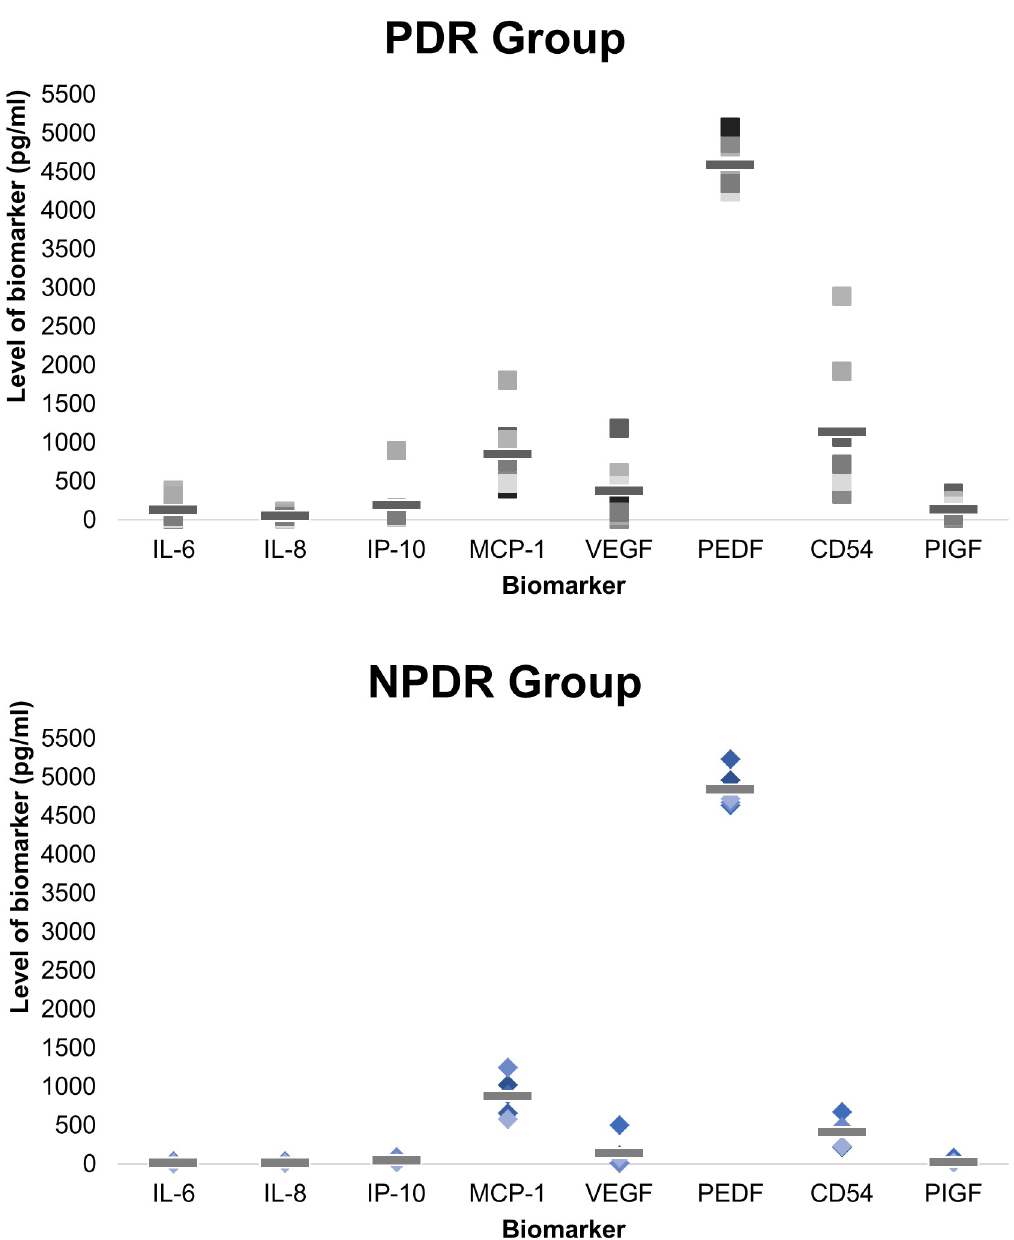
Fig 5. The levels of growth and inflammatory factors (GIF) in patients with proliferative diabetic retinopathy (PDR) (top panel) and non-proliferative diabetic retinopathy (NPDR) (bottom panel). Image notes: Individual data plotted using different shades of black (top panel) or blue (bottom panel) with the mean value shown as a solid horizontal line.